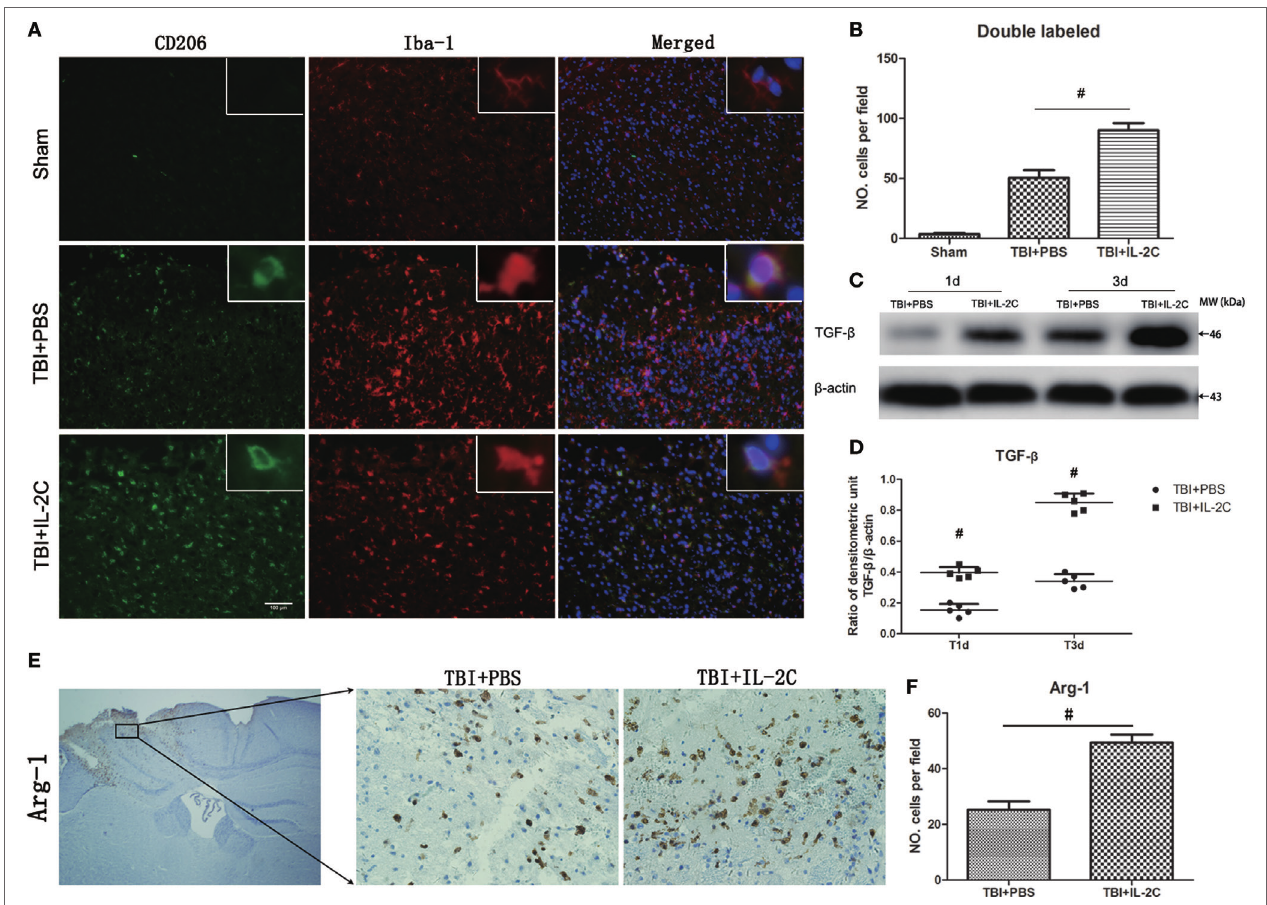
FigUre 11 | Treatment with IL-2C increased the expression of M2-associated markers in the contusion margin. (a) Co-localization of CD206 with the microglia marker Iba1 showed that IL-2C increased the number of M2 microglia on day 3 post-injury in the contusion area. (B) Cell count analyses indicated that IL-2C significantly increased the amount of CD206 and Iba-1-double-positive cells. (c,D) The traumatic brain injury TBI-induced expression of TGF- β in the ipsilateral cortices on days 1 and 3 post-injury was increased by treatment with IL-2C. (e,F) Immunohistochemistry showed that treatment with IL-2C significantly increased the number of arginase-1 + cells around the lesion area. Data are presented as the mean ± SD; * p < 0.05 and # p < 0.01 ( n = 5